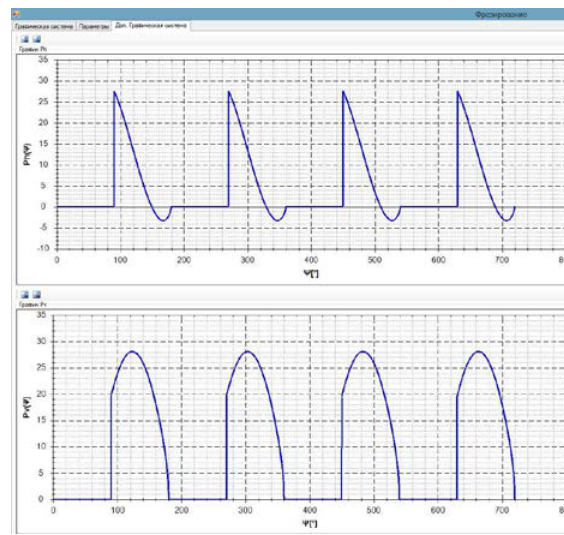
Fig. 4. The interface of the force parameter simulation